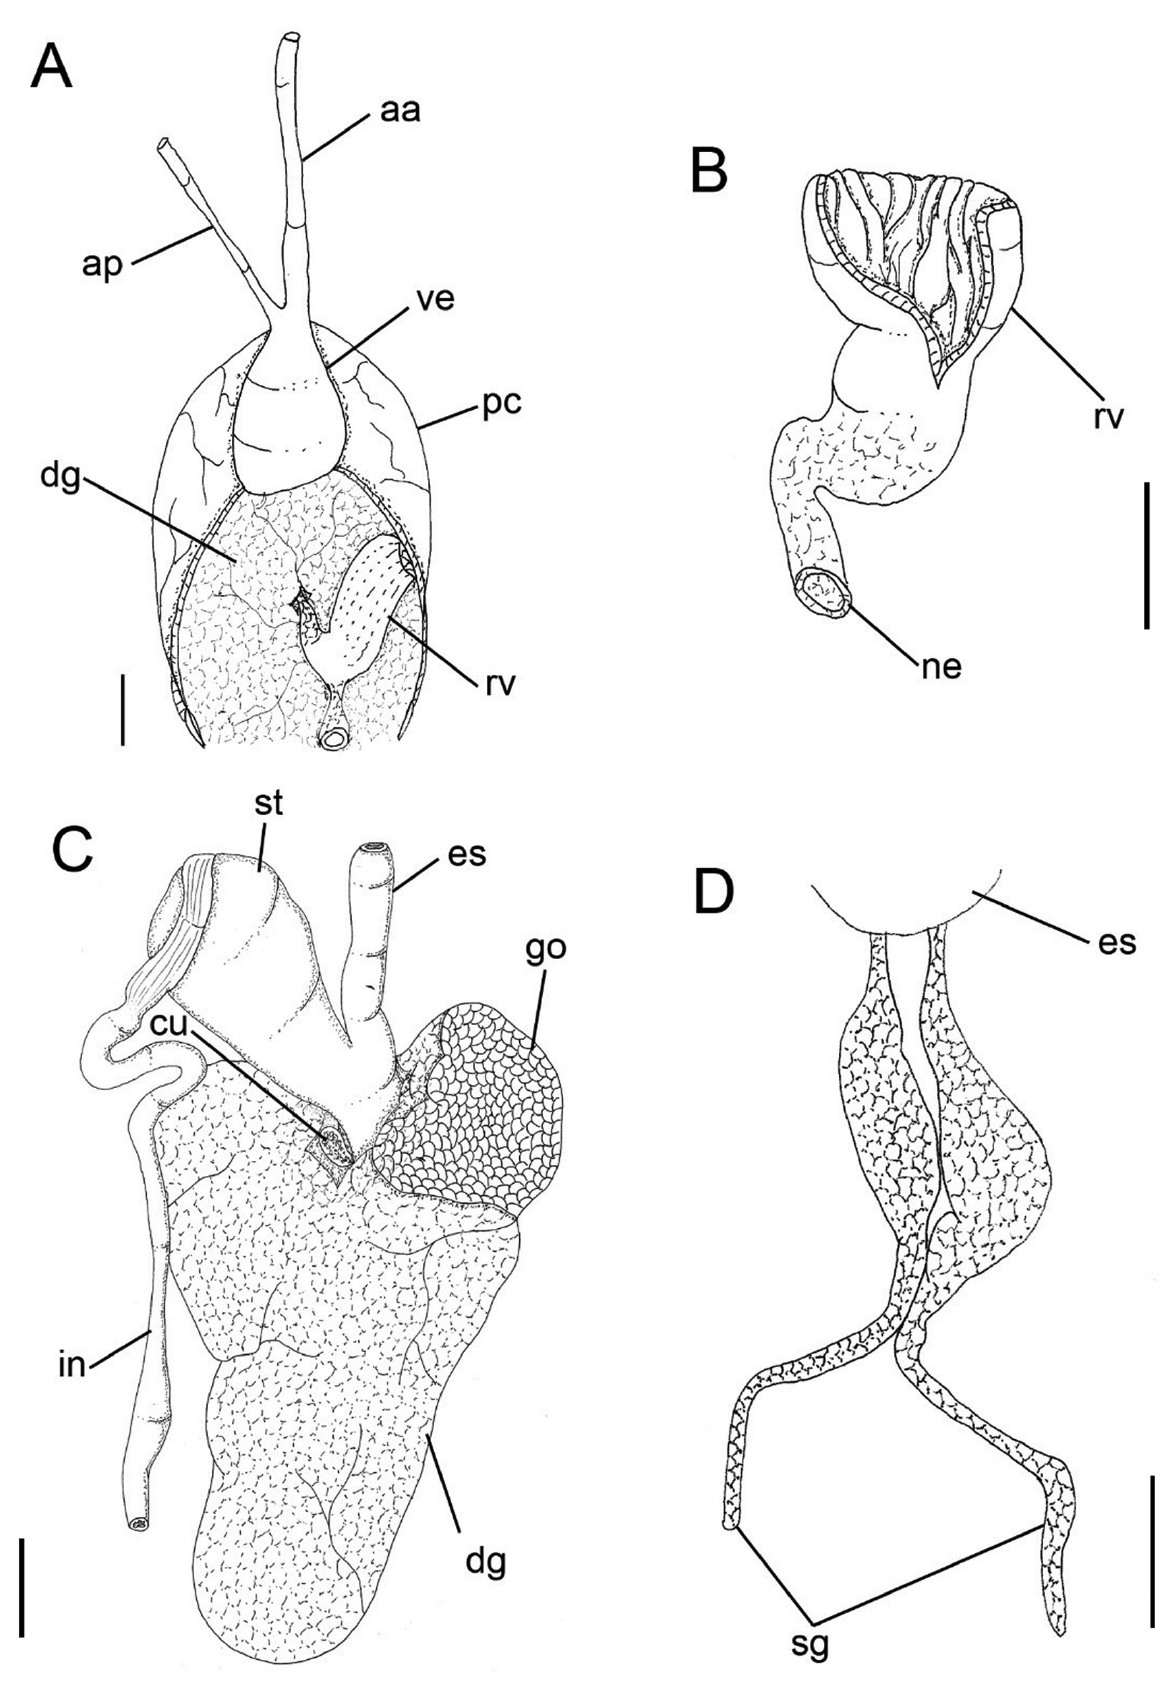
Figure 8. Platydoris guarani . A circulatory and excretory system, ventral view B renal vesicle C medium digestive system, dorsal view D detail of salivar glands. Scale bars: 2 mm ( A, B, D ); 5 mm ( C